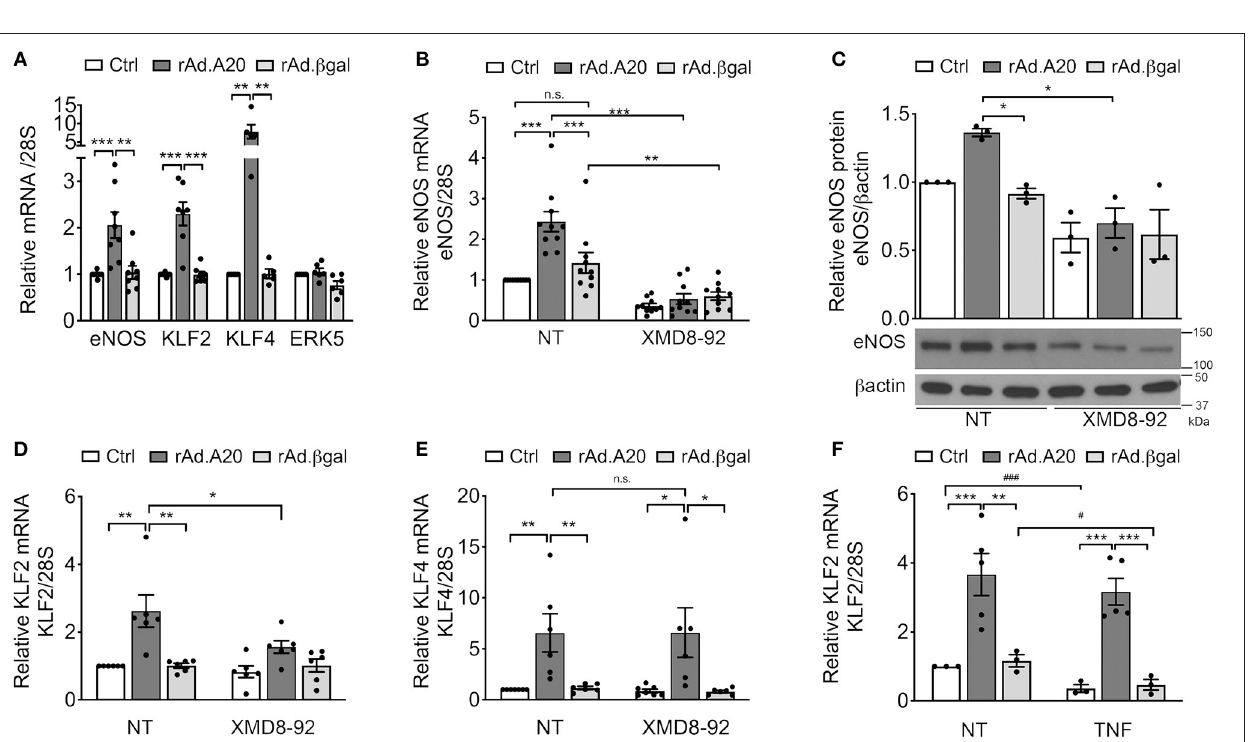
FIGURE 3 | A20 overexpression in HCAEC increases eNOS transcription in an ERK5-dependent manner. (A) mRNA levels of eNOS, KLF2, KLF4, and ERK5 were measured by qPCR in non-transduced HCAEC (Ctrl) and HCAEC transduced with rAd.A20 or control rAd. β gal at 100 MOI for 48h. Data were normalized by the 28S HKG and expressed as mean ± SEM fold change of Ctrl ( n = 5–9). (B) eNOS, (D) KLF2, and (E) KLF4 mRNA and (C) eNOS protein levels were measured by qPCR, and WB in non-transduced HCAEC (Ctrl) and HCAEC transduced with rAd.A20 or control rAd. β gal at 100 MOI for 3h prior to 24h treatment with the ERK5 inhibitor, XMD8-92 (10 µ M). Graphs in (B) , (D) , and (E) depict relative mRNA levels, normalized by the 28S HKG and expressed as mean ± SEM fold change of non-treated (NT) Ctrl ( n = 6–10). In (C) , β -actin was used to correct for loading. Densitometry results are presented as fold change of NT Ctrl cells ( n = 3). (F) KLF2 mRNA levels were measured by qPCR in non-transduced HCAEC (Ctrl) and in HCAEC transduced with rAd.A20 or control rAd. β gal at 100 MOI for 48h prior to 24h treatment with TNF (200 U/mL). Graphs depict relative KLF2 mRNA levels normalized by the 28S HKG and expressed as mean ± SEM fold change of non-treated (NT) Ctrl ( n